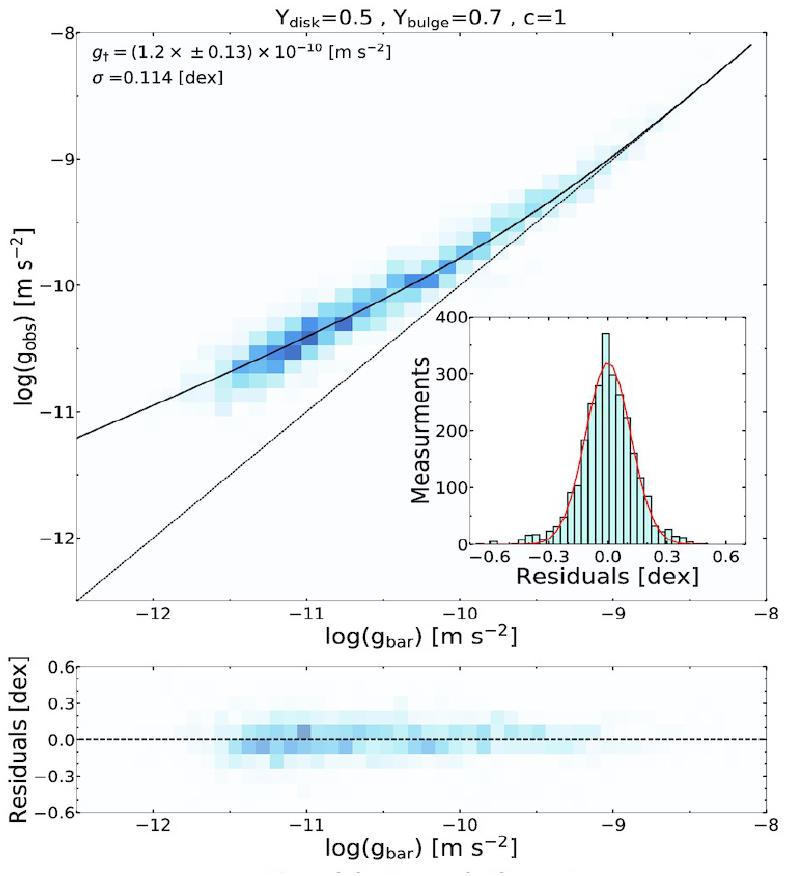
Figure 3. The radial acceleration relation (RAR) built from Spitzer photometry and accurate rotation curves (SPARC) galaxies. For each galaxy, a mass-to-light ratio in the 3.6 µ m band for the disk and the bulge equal to 0.5 and 0.7 M (cid:12) /L (cid:12) , respectively, is adopted. The black solid line represents the fit to the data with Equation (3) and the black dashed line is the g obs = g bar relation, for reference. The only best-fit parameter, g † , is highlighted in the top-left corner of the panel and it is 1 σ consistent with the acceleration scale a 0 . The histogram and the bottom panel show the distribution of the residuals of the observed RAR from Equation (3), and its standard deviation σ , which quantifies the RAR observed scatter, is shown in the top-left corner of the panel. The figure is re-adapted from Figure 2 in